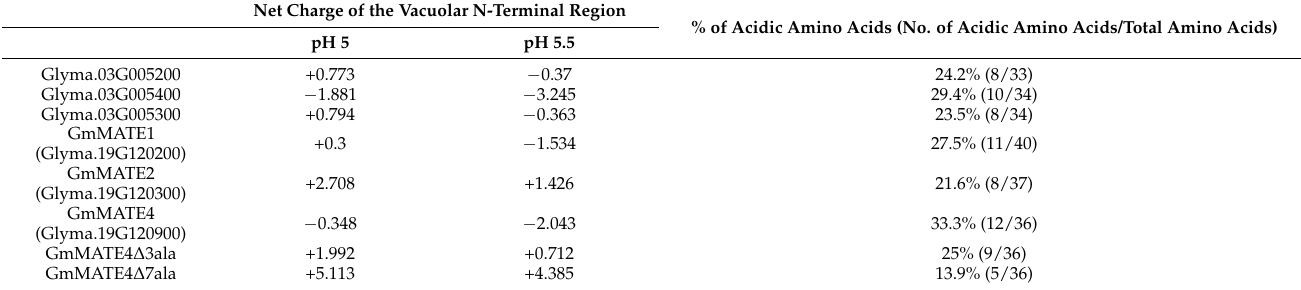
Table 1. Net charge prediction of the N-termini of MATE-type proteins.